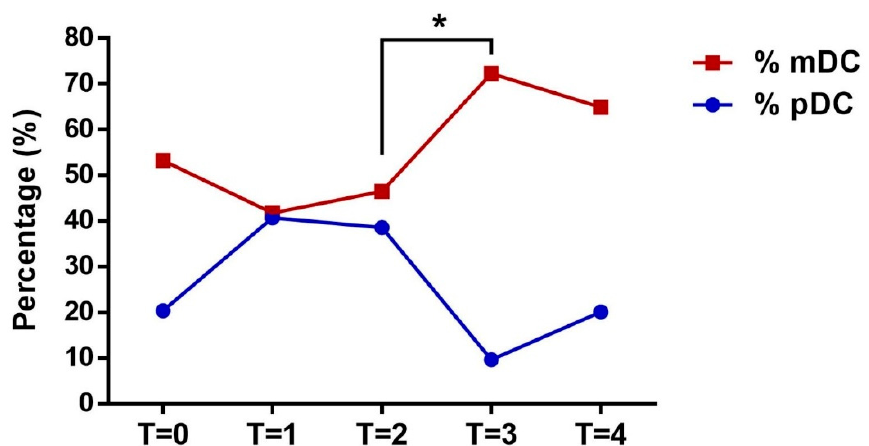
Figure 3. Analysis of mDC (red line) and plasmacytoid DC (pDC) (blue line) subtypes at different monitoring points (T0 to T4) according to the specific phenotypic markers Lin − HLADR+ CD11+/ − CD123 − /+. * Shows a strong maturation response observed for mDCs that mirrored by a decrease in pDCs.